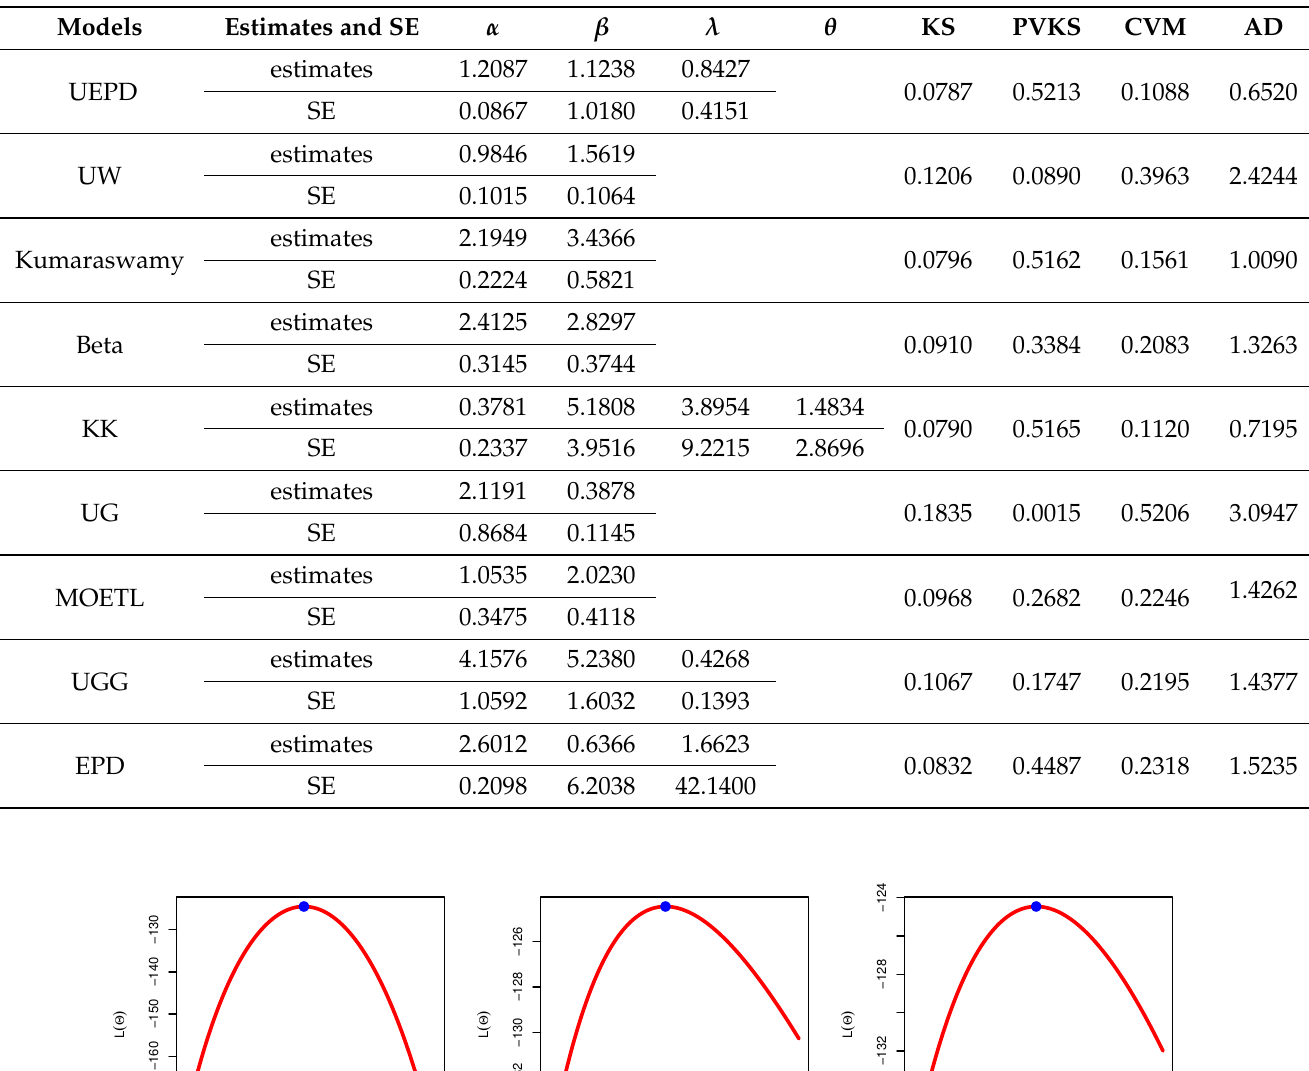
Table 8. M L E and SE with different measures of goodness of fit for milk production data.